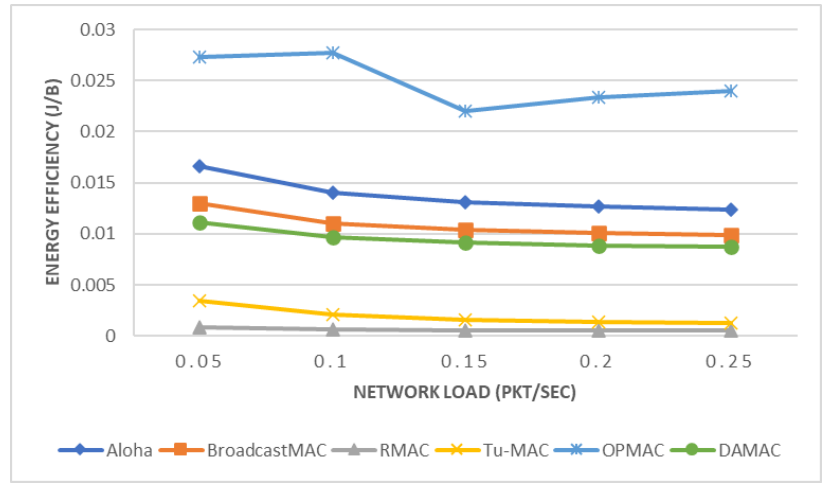
Figure 5. Energy